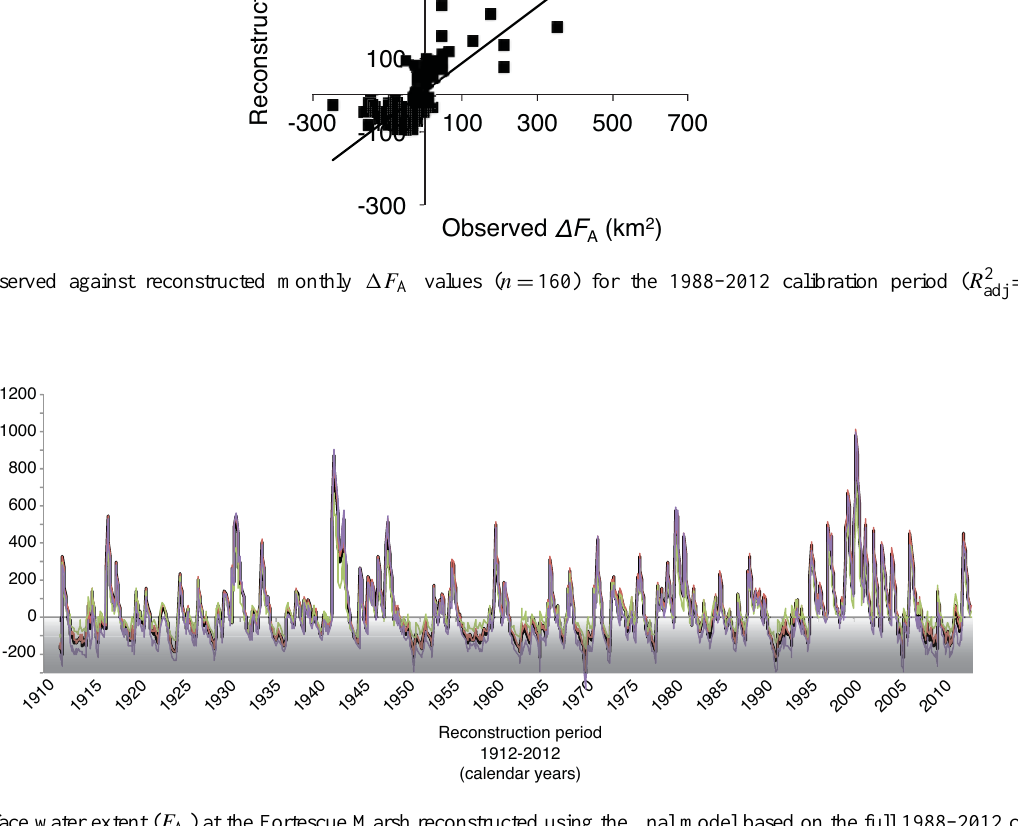
Figure A3. Surface water extent ( F A ) at the Fortescue Marsh reconstructed using the final model based on the full 1988–2012 calibration period (black line) and the subsets for the 1998–2012 (red line) 1988–1997; 2005–2012 (green line), 1988–2004 (purple line) periods; F A ≤ 0km 2 = no surface water evident on the Marsh